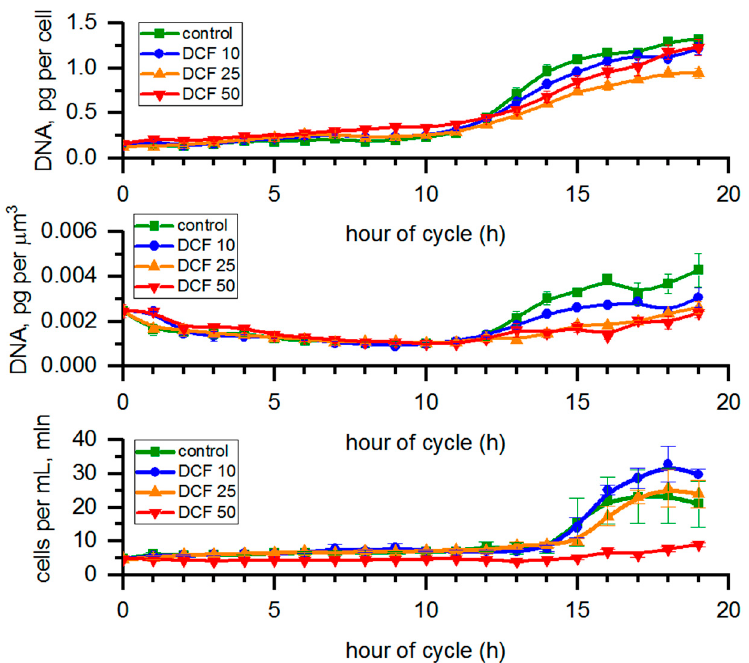
Figure 5. DNA content calculated per single mother or µ m 3 of total cell volume in sample and the number of cells per mL. Data are presented as means ± SE. Cell number of DCF50 and DNA content per µ m 3 of all DCF groups were statistically significantly different from controls (correlation comparison, p < 0.05, n = 3). Data of DNA content per cell are presented as pg per mother cells even at the time of cell division to allow simple comparison across the groups.